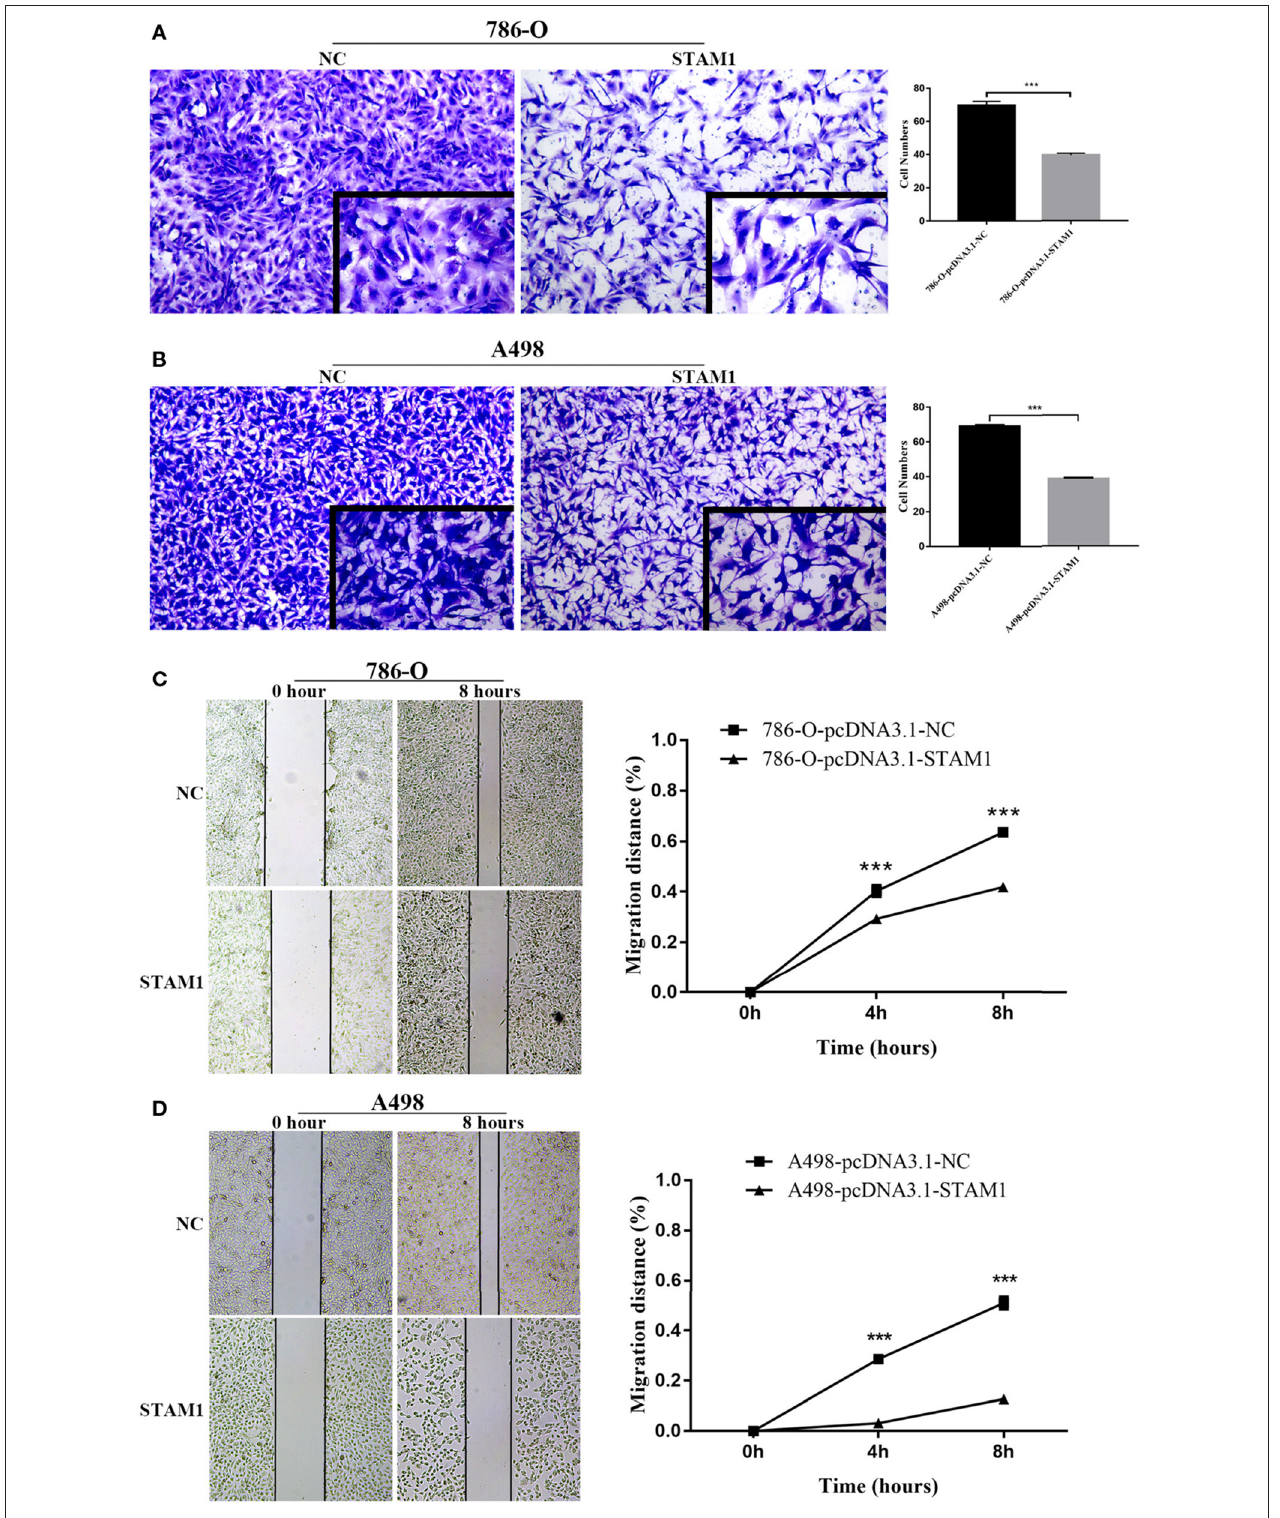
FIGURE 7 | Invasion and migration capability assessment after overexpressing STAM1 in 786-O and A498 cells. The invasion capability of 786-O (A) and A498 (B) cells was determined using the Matrigel transwell invasion assay. At 24h later, the cells that had passed though the membrane were calculated and compared to baseline levels. The motility of 786-O (C) and A498 (D) cells was detected by the wound-healing assay. Migration distances compared to baseline were measured after 4 and 8h. *** p < 0.001.